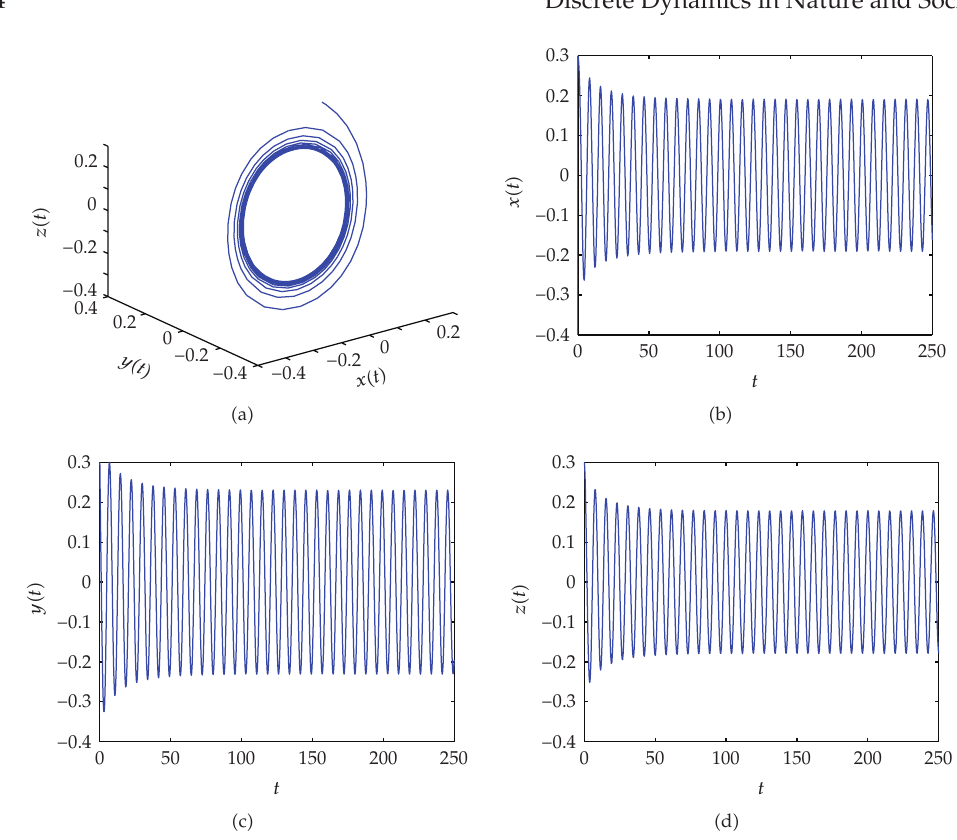
Figure 3: Phase portrait and waveform portraits of system (cid:4) 2.2 (cid:5) with τ (cid:6) 0 .